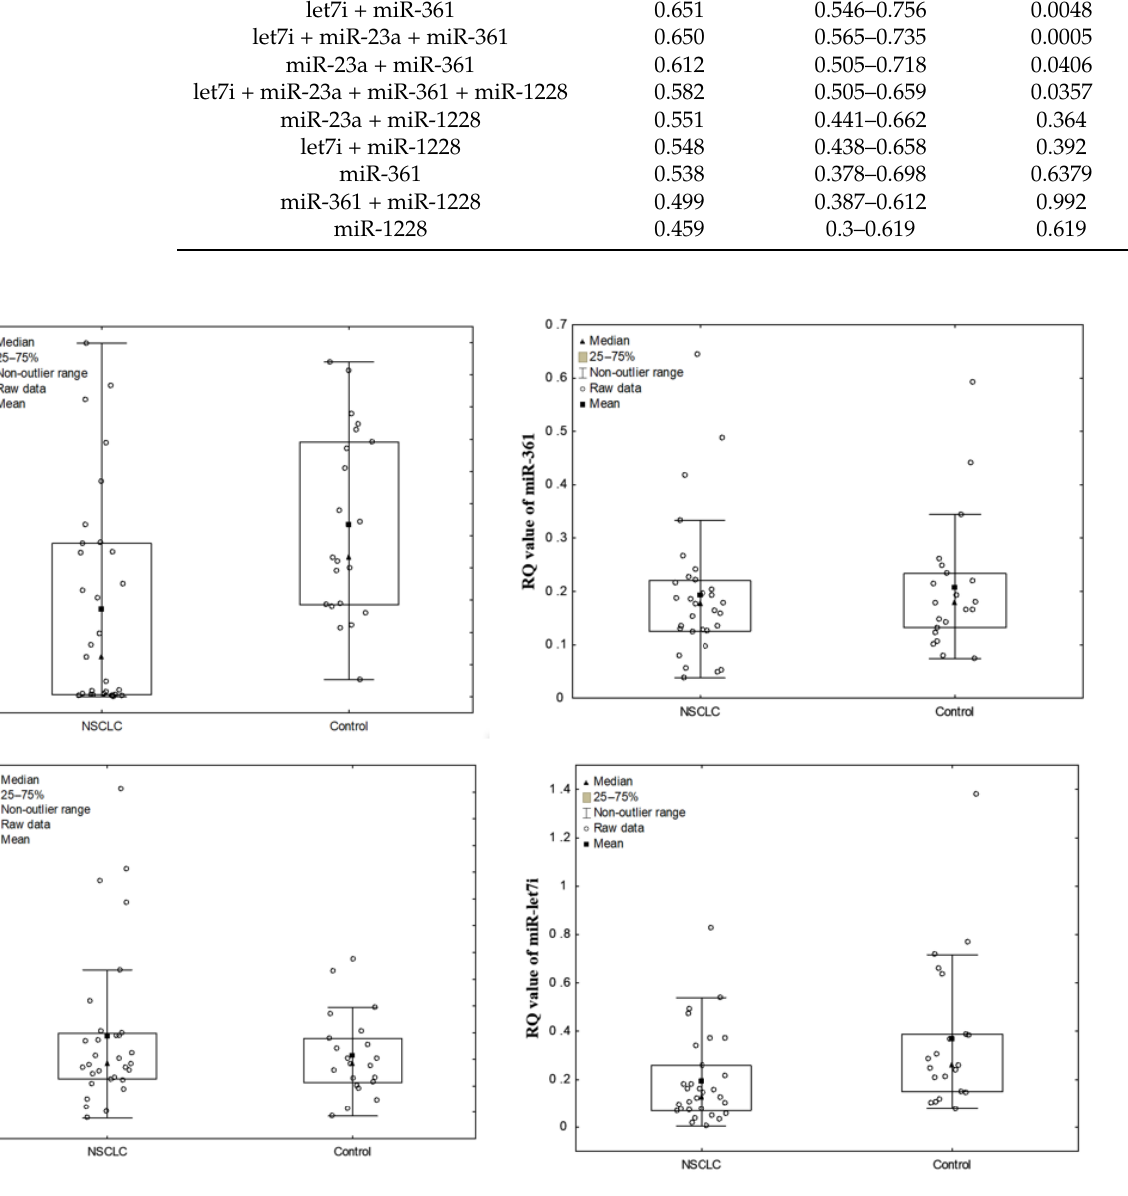
Figure 1. The dot plots, representing miRNA levels (RQ values) in NSCLC samples and control